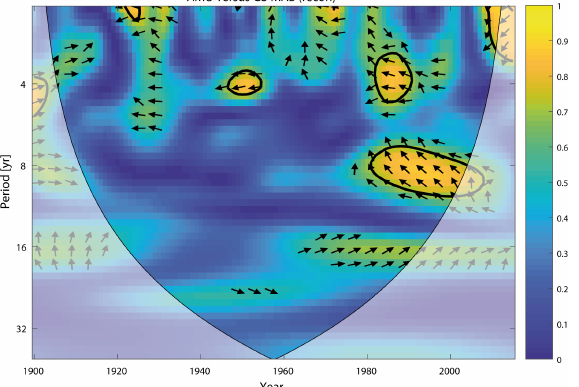
Figure A3. Squared wavelet coherence between the AMO index and GS-MAB time series. The 5% significance level against red noise is shown as a thick contour. All significant sections (mostly after the 1980s) for periods below 10 years show antiphase behavior, which is indicated by arrows that are directed to the left. Positive, through statistically nonsignificant, correlations are found in the 16-year bands since the 1960s and confirm the low-frequency modes identified by the EMD in the main